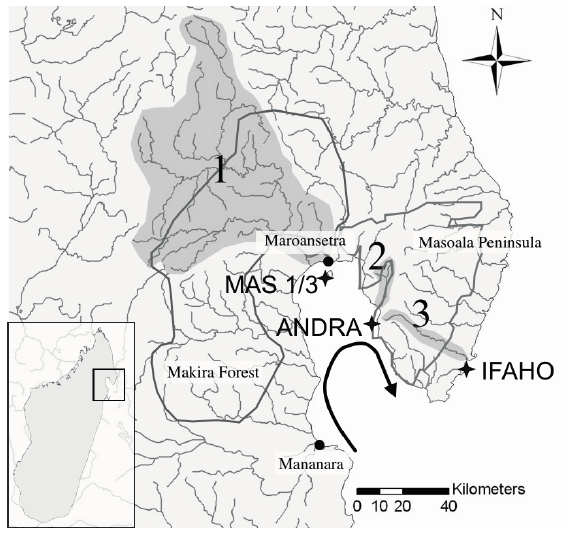
Fig. 1. Map of Antongil Bay in NE Madagascar showing the three coral sites (stars) and closest rivers with respective water- sheds (grey shaded areas). Rivers are marked by the numbers 1 (MAS1, Antainambalana River), 2 (ANDRA, Ambanizana River) and 3 (IFAHO, Anaovandran River). The bay circulation is marked by an arrow indicating a clockwise direction. The location of towns (black circles) and national park boundaries (Makira-Masoala Pro- tected Landscape; think grey lines) are marked on the map accord-